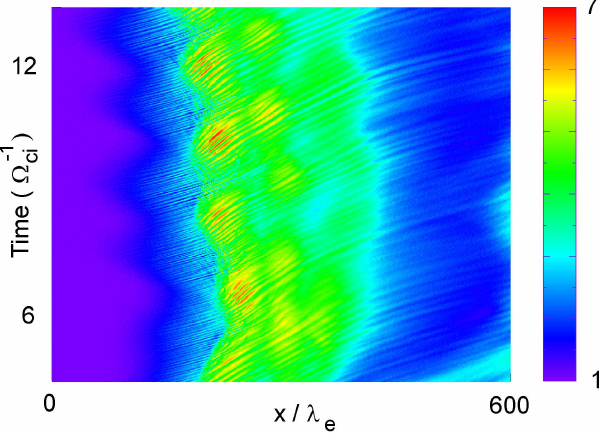
Fig. 1. Color coded magnetic field B z component in the t − x plane. The magnetic field has been shifted into an average frame standing with the shock.